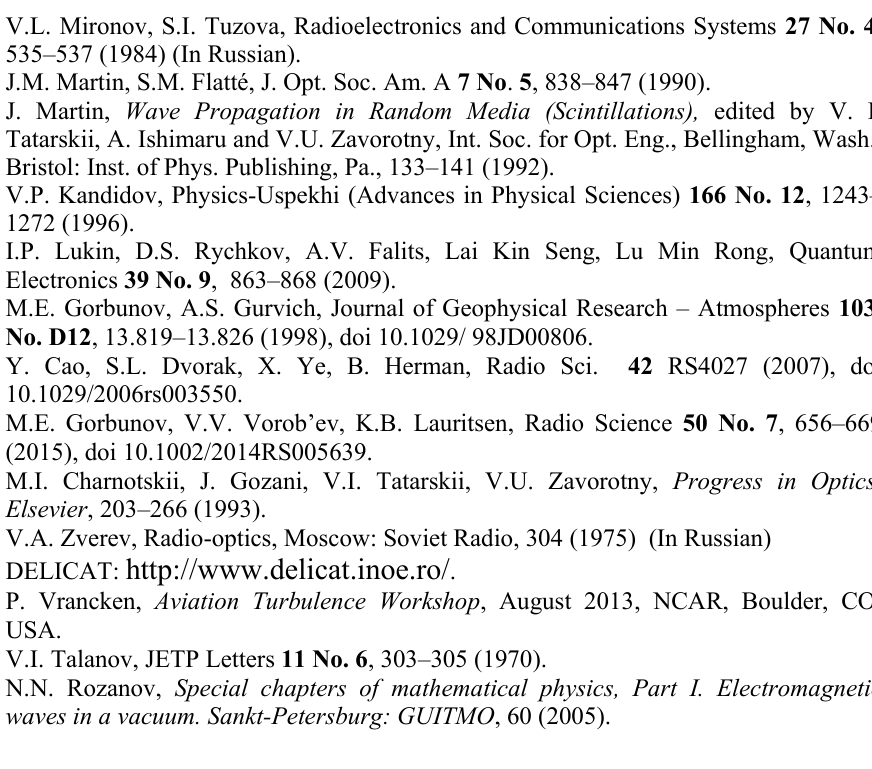
Fig. 1–2 show examples of a numerical calculation of the amplitude distributions of a Gaussian laser beam with a wavelength